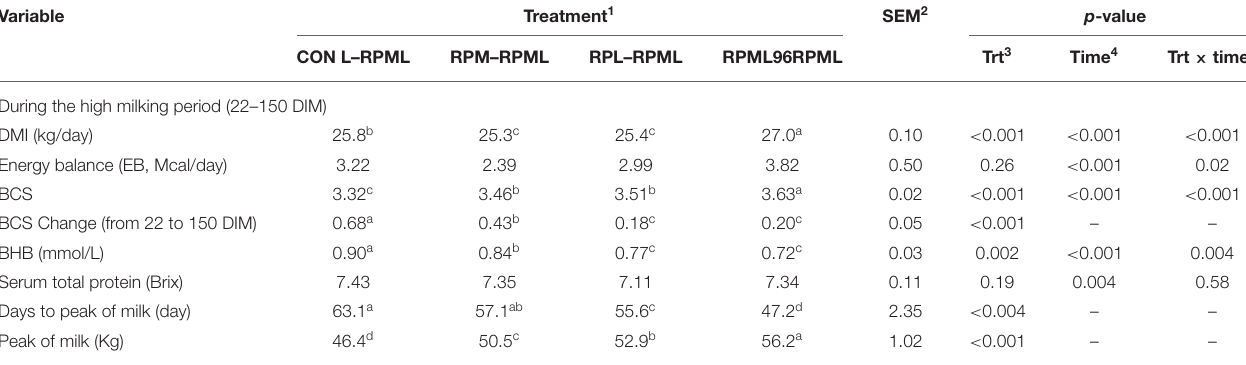
TABLE 4 | Feeding ruminally protected Met and Lys to transition dairy cows and its subsequent effect on post-calving performance. Variable Treatment 1 SEM 2 p -value CON L–RPML RPM–RPML RPL–RPML During the high milking period (22–150 DIM) DMI (kg/day)